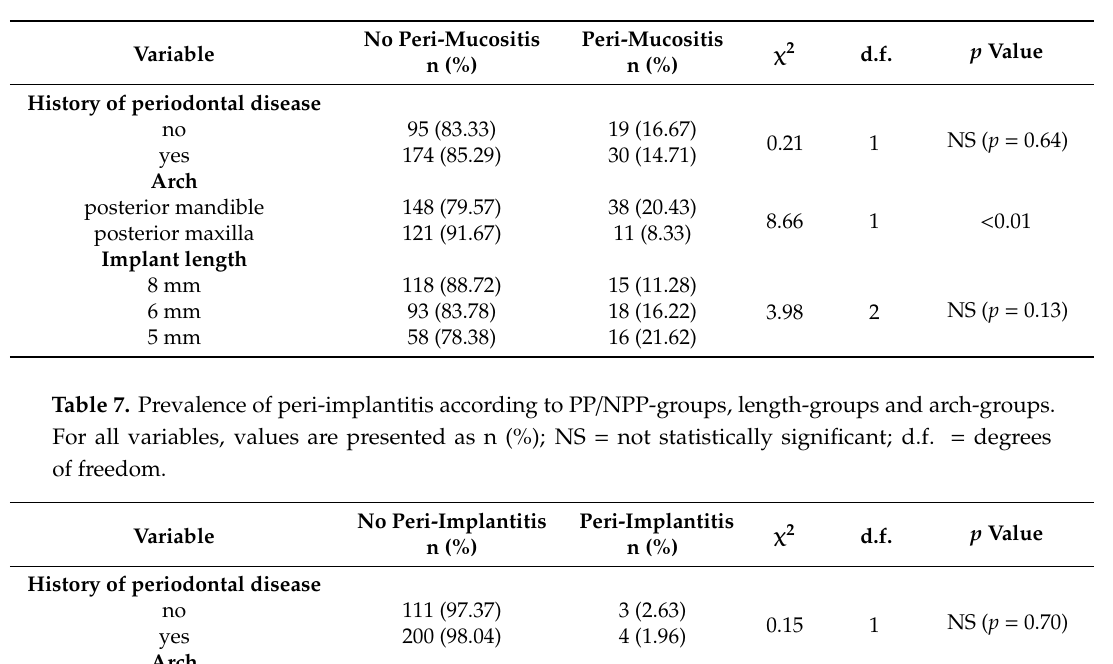
Table 6. Prevalence of peri-mucositis according to PP / NPP-groups, length-groups and arch-groups. For all variables, values are presented as n (%); NS = not statistically significant; d.f. = degrees of freedom.